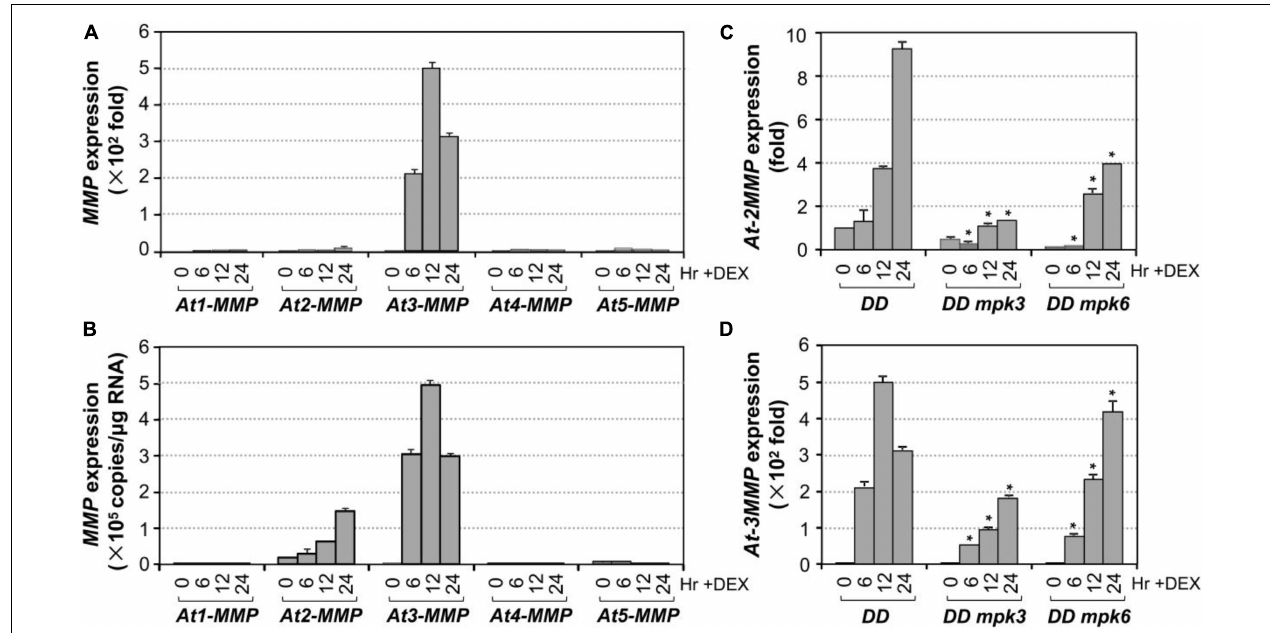
FIGURE 4 | Induction of Arabidopsis MMP genes expression after MPK3/MPK6 activation in the gain-of-function DD seedlings. (A) The induction of MMP gene expression was quantified by RT-qPCR. MMP induction (fold of induction relative to the level before induction) was calculated using the double (cid:49) Ct method. The expression of EF1 α was used to normalize the samples. (B) Absolute expression levels of MMP induction was calculated as copies numbers per µ g of total RNA by the calibration curve established for each MMP gene, which allows comparison to expression levels between different MMP genes. Values were means ± SD, n = 3. (C,D) Activation of At2-MMP (C) and At3-MMP (D) expression in the DD seedlings were compromised in either mpk3 or mpk6 mutant background. Gene expression was quantified by RT-qPCR and calculated as in (A) . Asterisks indicate a significant difference ( P ≤ 0.001). Values were means ± SD, n =